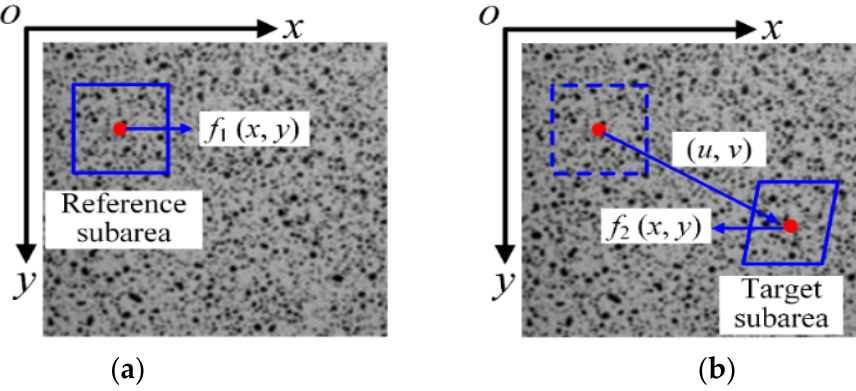
Figure 4. Sketches of correlation match: ( a ) reference image; ( b ) deformed image.